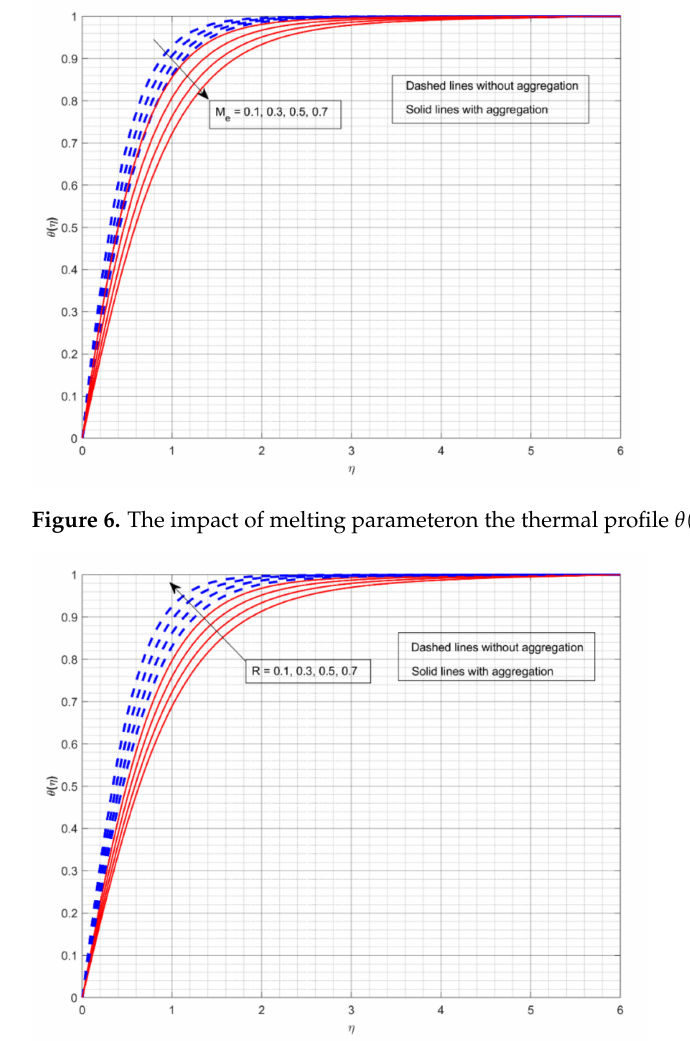
Figure 7. The impact of radiation parameter on the thermal profile θ ( η )